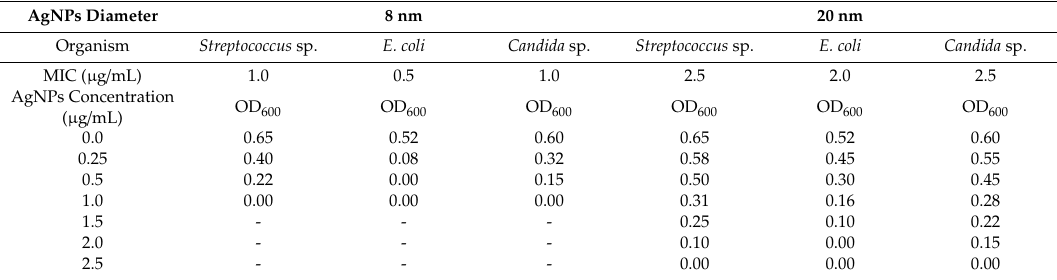
Table 2. OD 600 values and relative MIC of AgNPs with di ff erent diameters towards di ff erent pathogens. AgNPs